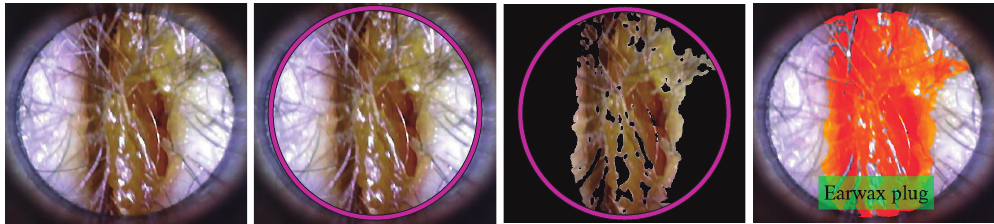
Fig 9. Earwax plug case: If the system classified the RGB input image as earwax plug condition, it highlights the area with wax found in the eardrum or the ear canal. From left to right: RGB input image, region of interest, wax segmentation and area under medical suspicion highlighted.